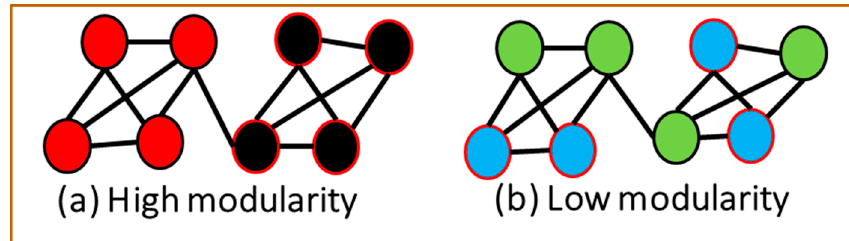
Figure 33. Overview of the high and low modularity in a graph (Ref. [128]).